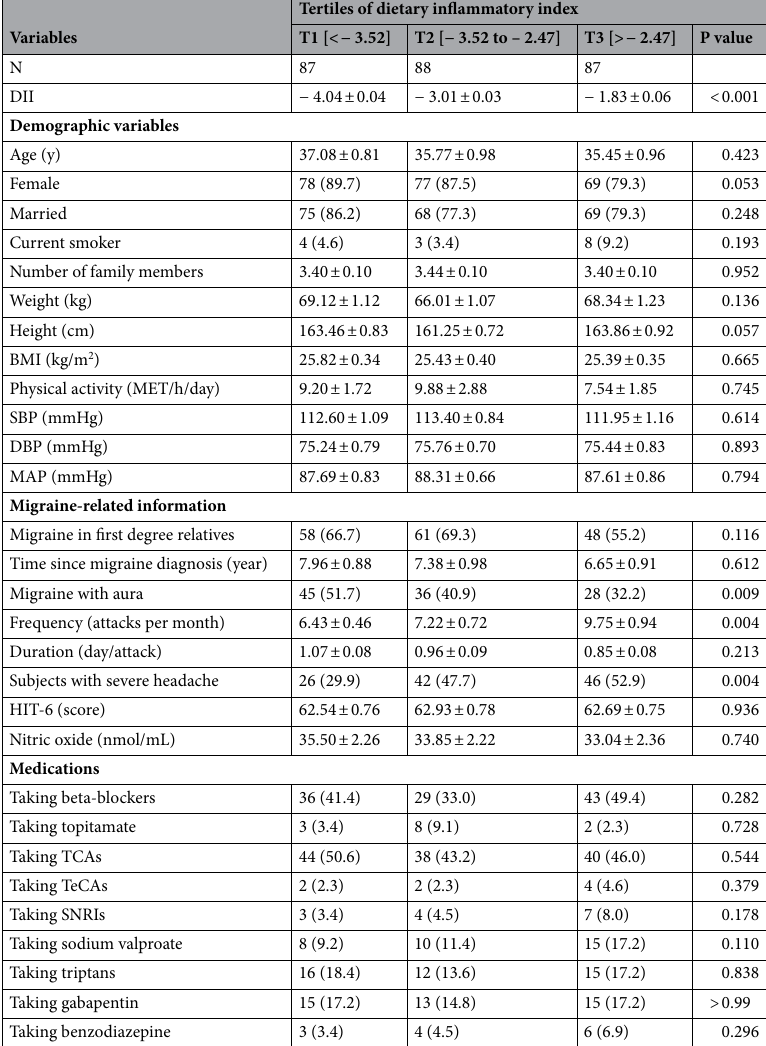
Table 1. Characteristics of study population stratified by tertiles of dietary inflammatory index. Data are presented as mean ± standard error or number (% within tertiles of dietary inflammatory index). P value obtained from chi-square analysis for categorical variables and analysis of variance (ANOVA) for continuous variables. BMI body mass index, SBP systolic blood pressure, DBP diastolic blood pressure, MAP mean arterial pressure, TCA tricyclic antidepressants, TeCA tetracyclic antidepressant, SNRI serotonin-norepinephrine reuptake inhibitor, HIT headache impact test, DII Dietary Inflammatory